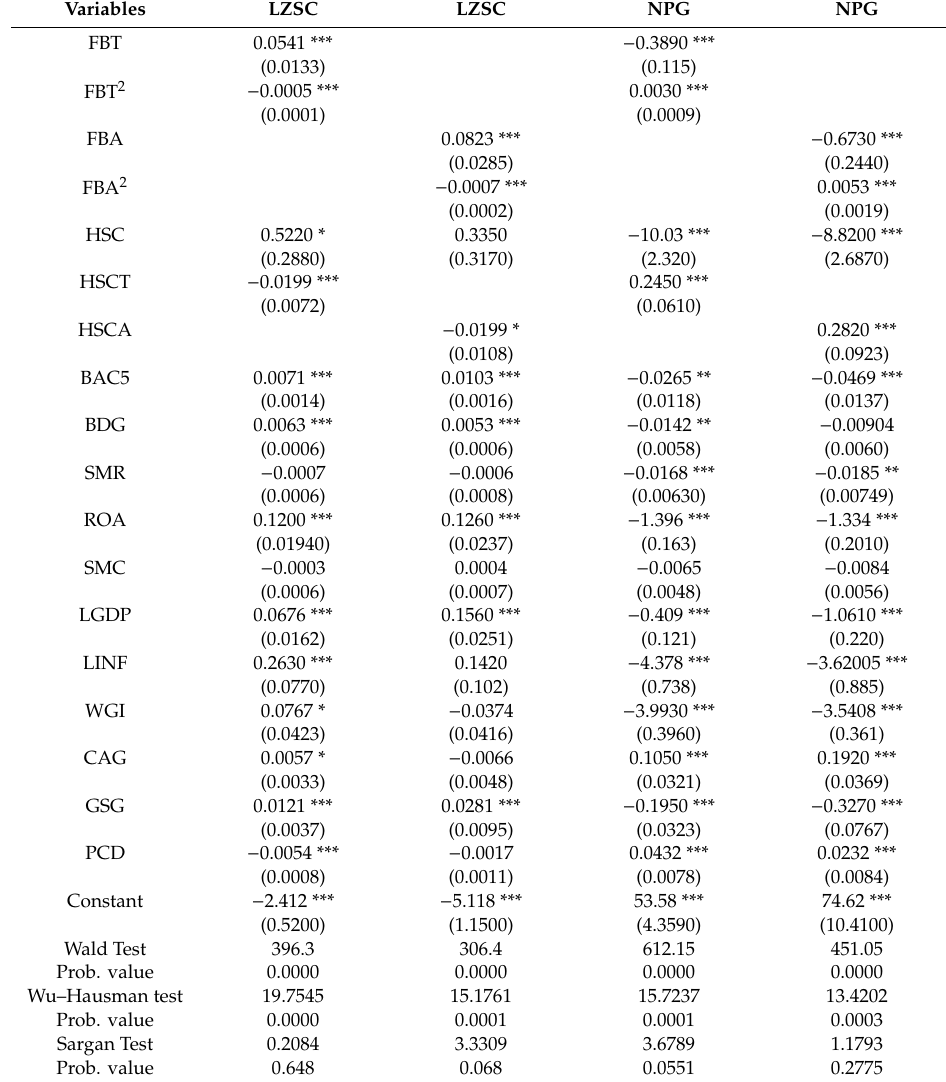
Table 8. Bank competition, foreign bank entry, and banking risk (2SLS